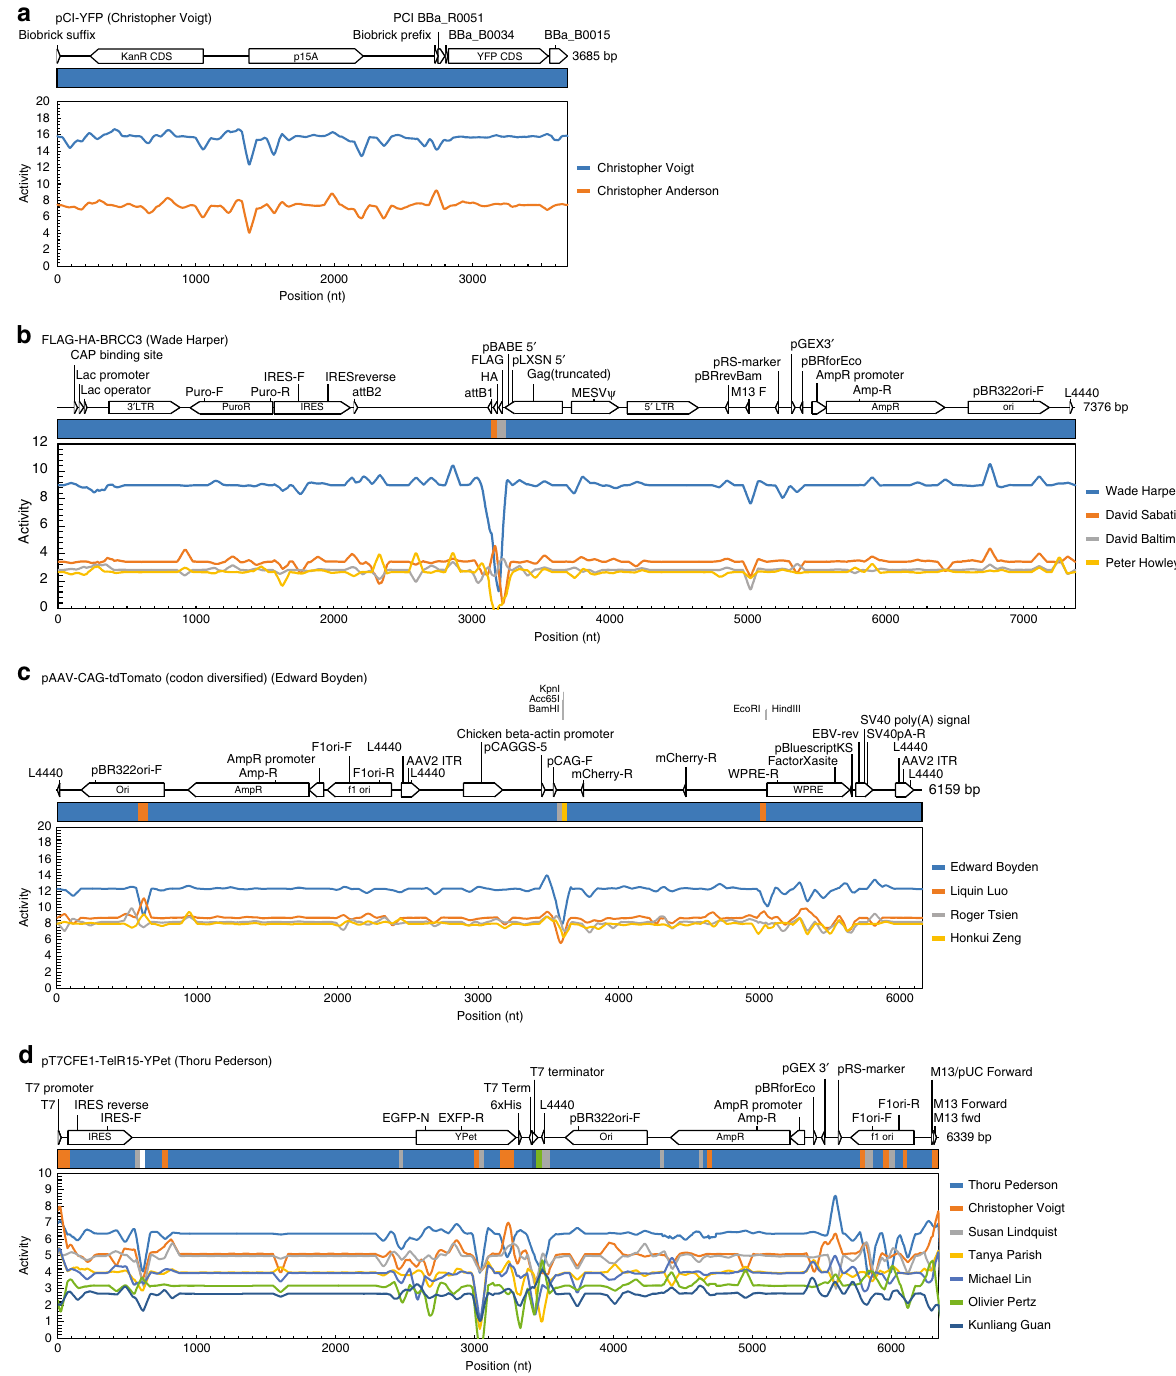
Fig. 4 Plasmid disruption analysis. Sequence scanning for plasmids a pCI-YFP from Christopher Voigt ’ s lab, b FLAG-HA-BRCC3 from Wade Harper ’ s lab, c pAAV-CAG-tdTomato (codon diversi fi ed) from Edward Boyden ’ s lab, and d pT7CFE1-TelR15-YPet from Thoru Pederson ’ s lab. Genetic schematics with feature annotations from the plasmid dataset fi le shown at the top of each panel. Colored bars display the lab prediction when the corresponding region of the plasmid is obscured by a sliding window of 50 Ns (widths not to scale); colors correspond to the lab legend (right) and white corresponds to a lab not present in the legend. Colored traces show the average pre-softmax neural activity ( “ Activity ” ) for top predicted labs as each region of the plasmid is obscured. For each nucleotide position, average activations are calculated for all 50 frames where the disruption window obscures that to accelerate deep network training by reducing covariate shift 74 . We used the recti fi ed linear unit (ReLU) activation function for the convolutional and fully connected layers, the adam optimizer function for training, a categorical cross-entropy loss function to back-propagate errors from the output, and a mini- For the convolutional layer, we used the Keras border mode same to batch size of 8 inputs per update. To compensate for skewed plasmid deposit generate output vectors with the same size as the input. Batch normalization layers numbers across labs, we used the Keras class_weight variable to weight (used after the max-pool layer and the fi rst fully connected layer) have been shown